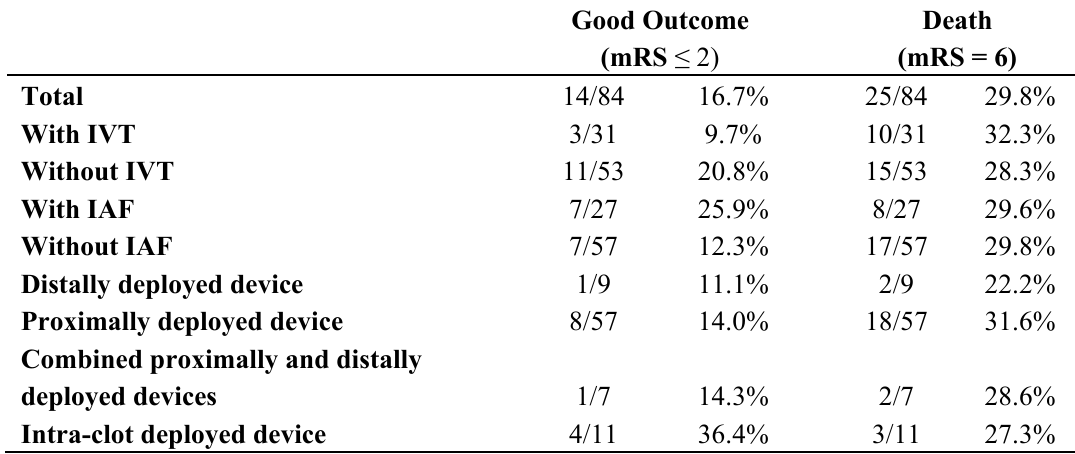
Table 4. Functional outcome stratified by type of device used and by adjunctive administration of fibrinolytic